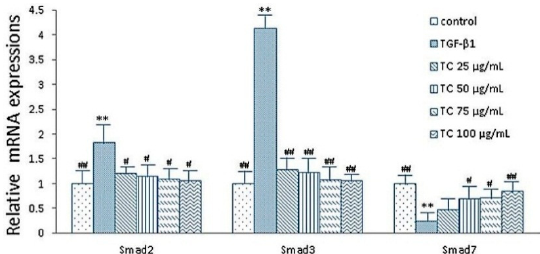
Figure 3. Effects of CPhGs on the expressions of smad2, smad3 and smad7 in HSC (RT-PCR assay). Data were expressed as mean ˘ SD. ** p < 0.01 compared with control group, # p < 0.05, ## p < 0.01 compared with TGF- β 1